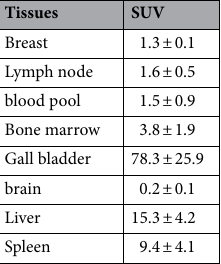
Table 3. Showing SUV in the various